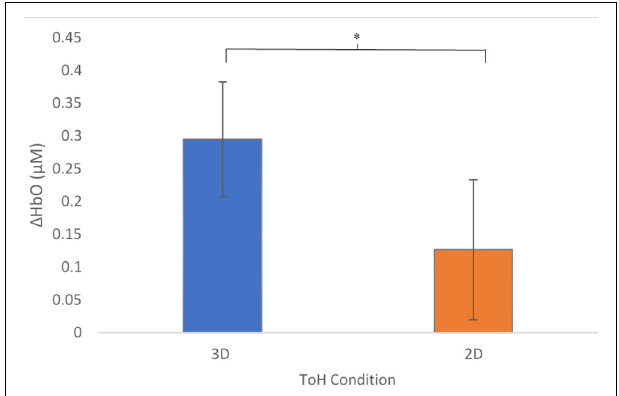
FIGURE 4 | Mean Changes in oxygenated hemoglobin, ∆ HbO ( µ M) as a function of condition. The 3D condition showed significantly higher activity, p = 0.0207. Error bars show standard error values. ∗ denotes statistical significance.